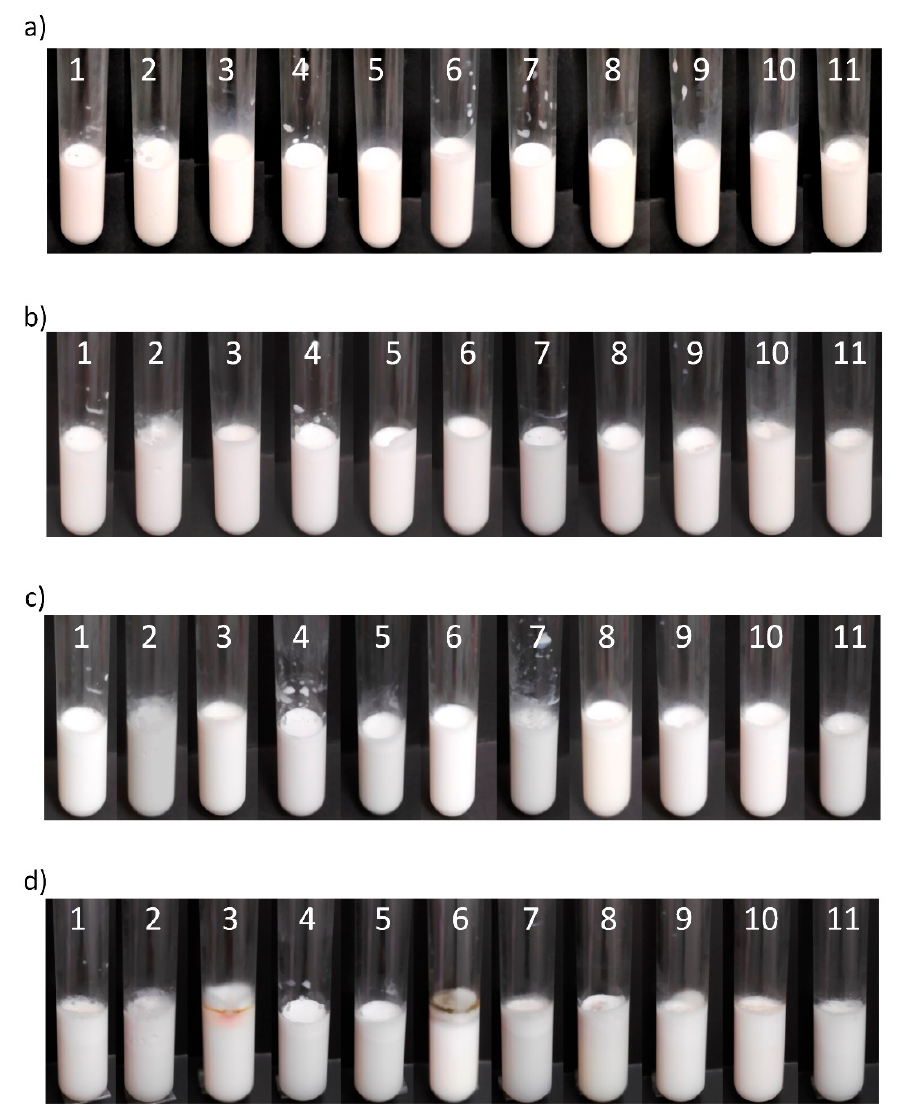
Figure 2. ( a ) Nanoemulsions prepared by HPH are shown on the preparation day. The evolution of their stability is shown after ( b ) 5, ( c ) 10 and ( d ) 30 days.